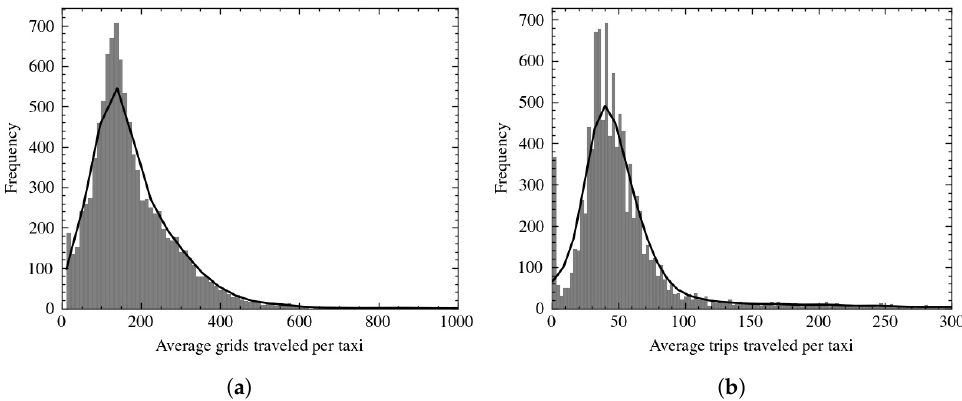
Figure 2. Distribution of data after segmentation. ( a ) Average grids traveled per taxi. ( b ) Average trips traveled per